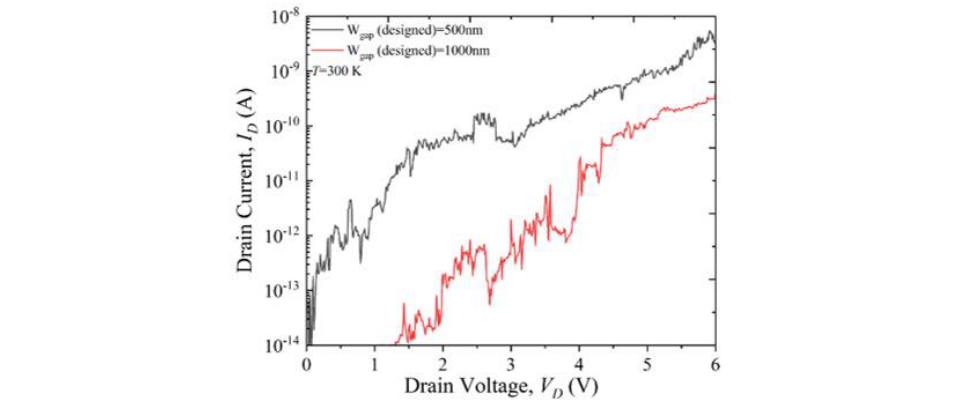
Figure 3. Room temperature I D – V D characteristics for two CNT-FETs from the same sample (black curve for a designed gap = 500 nm (FE-SEM images shown in Figure 2a,b) and red curve for a designed gap = 1000 nm (FE-SEM images shown in Figure 2c,d)).